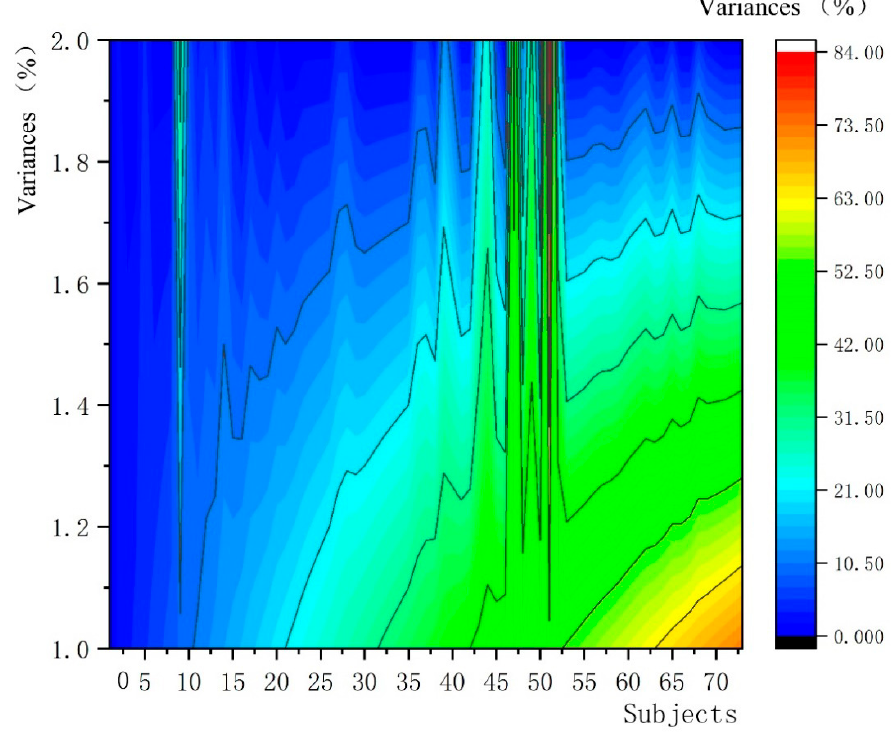
Figure 9. Trend chart of skin conductance wave value variance of subjects. Source: ErgoLAB platform derived the data and calculated that the minimum variance of skin conductance was 0, the maximum was 84%, and the average wave value was 5.819%.